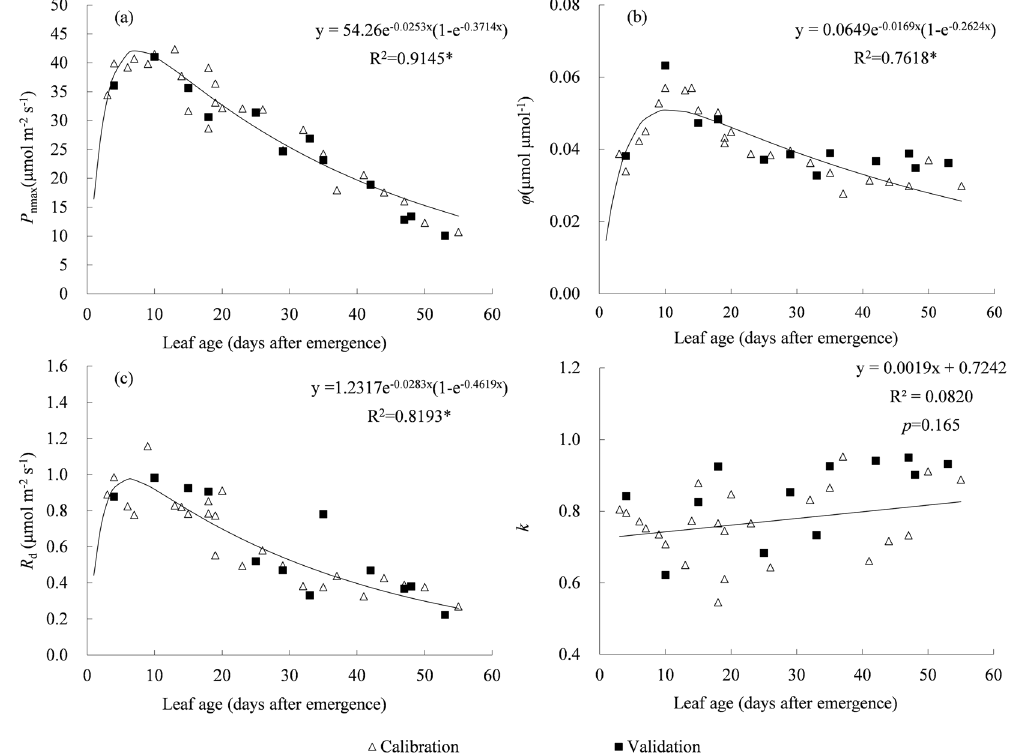
Figure 4. Regressions of ( a ) light-saturated net photosynthetic rate ( P nmax ), ( b ) quantum yield of assimilation ( ϕ ), ( c ) dark respiration rate ( R d ), and ( d ) convexity of the curve ( k ) with leaf age. (asterisk means significant relationship at p < 0.001 confidence level with